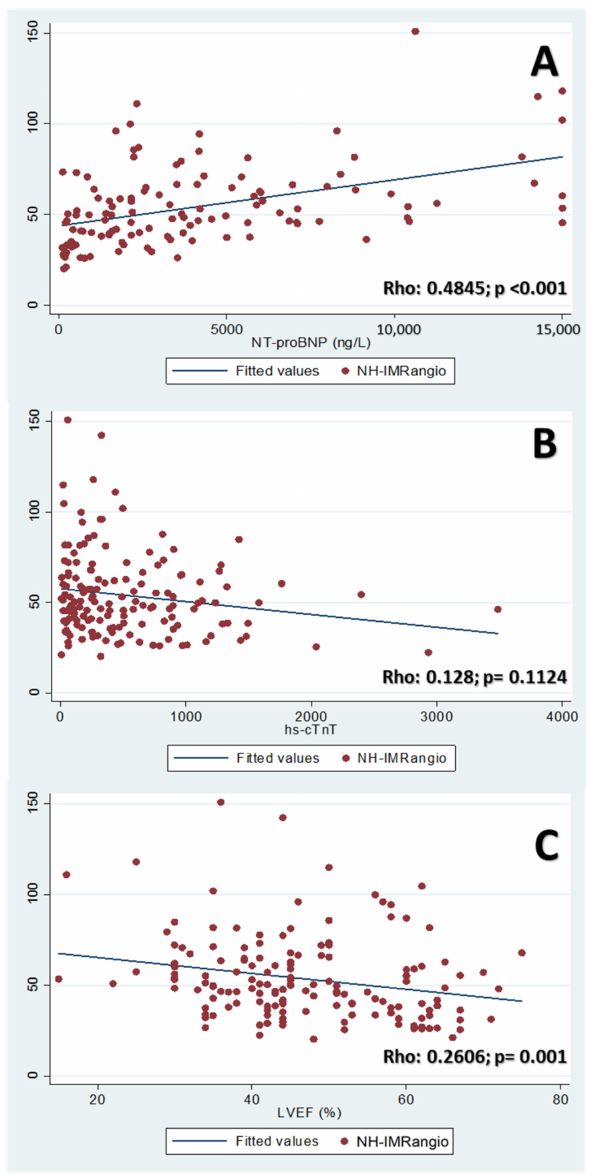
Figure 4. Correlations of NH-IMRangio with biomarkers and left ventricular ejection fraction (LVEF). Panel ( A ): Correlation between NT-proBNP values (pg/mL) and NH-IMRangio. Panel ( B ): Correlation between high-sensitive cardiac troponin T values (ng/L) and NH-IMRangio. Panel ( C ): Correlation between LVEF values (%) and